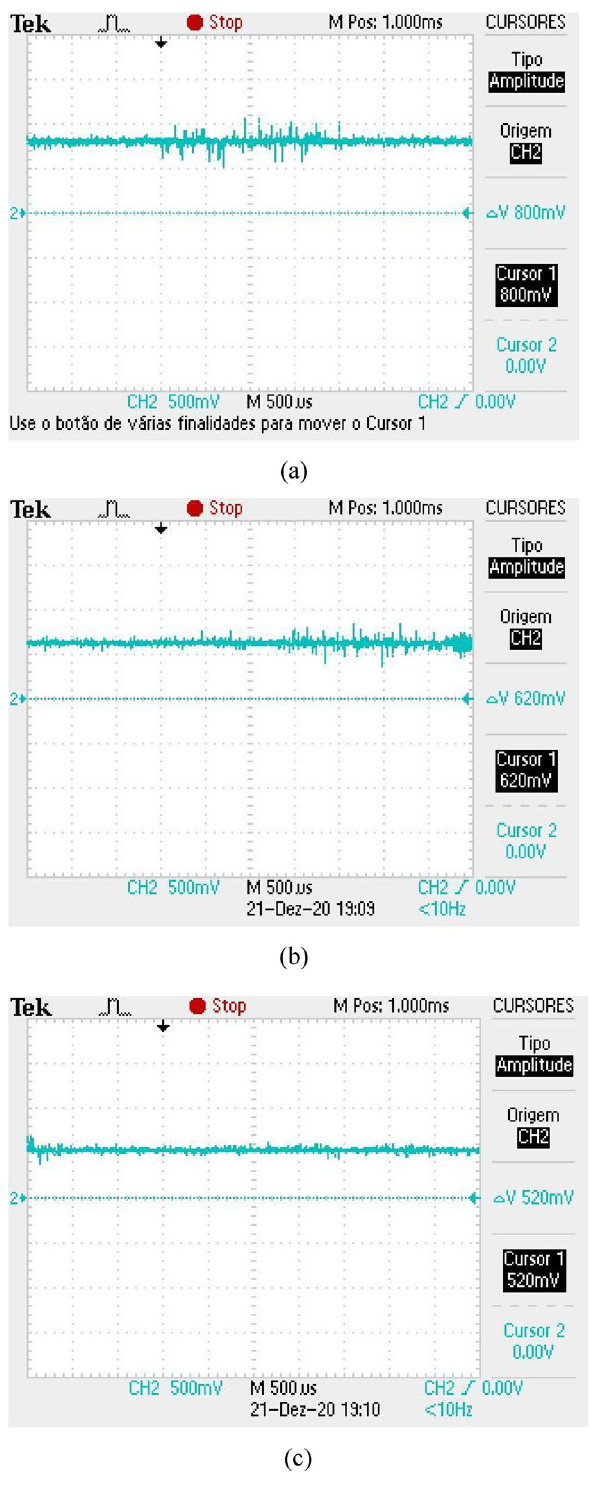
Figure 11. Reading of the DC level of the received signal for the first version of the Osseus : ( a ) without finger, ( b ) with finger in the correct decision and ( c ) with the finger in the rotated